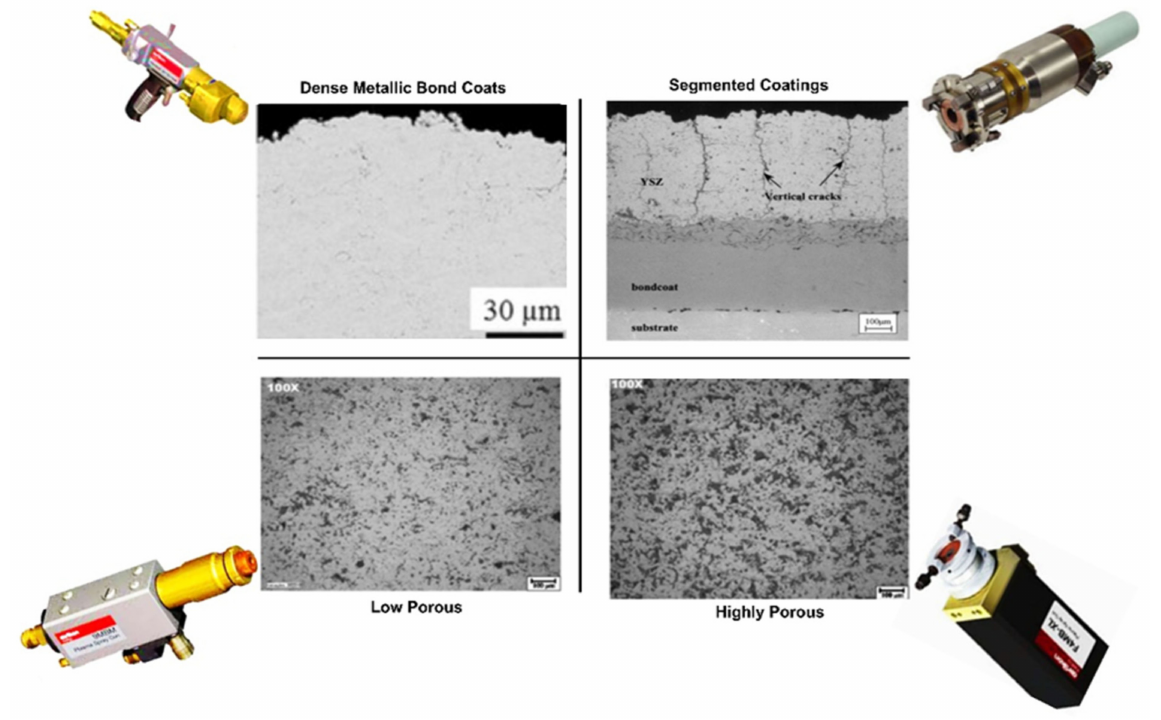
Figure 10. The gun arsenal and their capability to produce microstructures: dense metallic bond coat (HVOF DJ2600 gun), segmented coatings (Plazjet 200 kW gun), low porous TBC (9MB gun), and high porous TBC (F4MB gun)